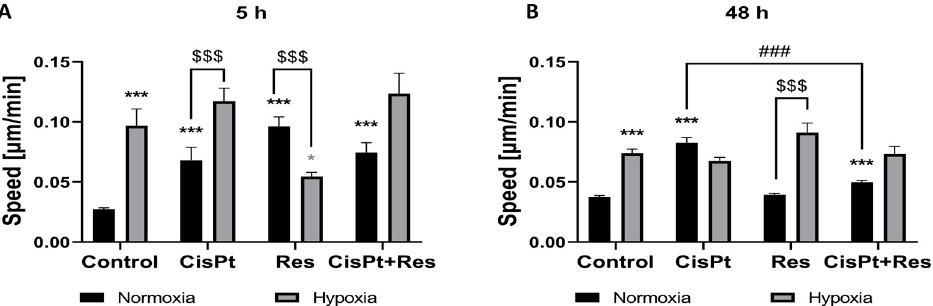
Figure 8. Hypoxia-dependent modification of migration of A2780 cells upon cisplatin, resveratrol, and the combination treatments. The cells were treated with cisplatin (CisPt), resveratrol (Res), and both in combination (CisPt+Res) according to Section 4.4: Establishment of Hypoxic Culture Conditions and Experimental Outline. The cell migration activity was recorded for 48 h with a time step of 20 min at 5× magni fi cation, using Zeiss Axio Observer microscope Z1/7–software Zen 2.6 (Blue edition). The speed of 50 single non-proliferating cells after treatment with CisPt, Res, and CisPt+Res under normoxic and hypoxic conditions was analyzed ( A ) at the 5 h time-point and ( B ) at the 48 h time-point. The results of three independent replicates are presented with the mean values ± SEM (total n = 150) with *** p < 0.001, * p < 0.05, vs. normoxia control (black asterisk) and vs. hypoxia control (grey asterisk); $$$ p < 0.001, comparing the normoxia group with the hypoxia group; and ### p < 0.001, CisPt alone vs. CisPt+Res.